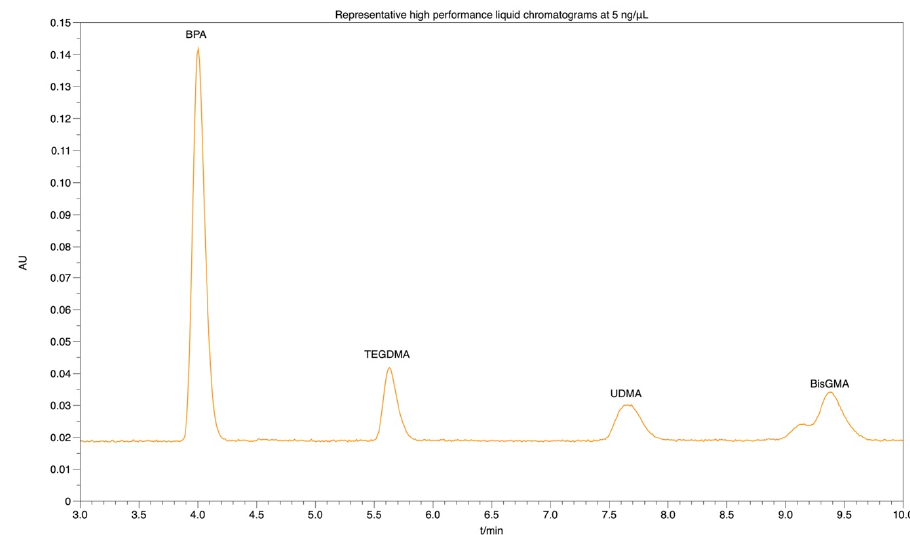
Figure 1. Representative high-performance liquid chromatograms at 5 ng/mL standard solution of BPA, TEGDMA, UDMA, Bis-GMA. Chromatographic conditions described in text. Bisphenol A ethoxylate dimethacrylate; Bis-GMA, bisphenol A-glycidyl dimethacrylate; BPA, bisphenol A; TEGDMA, triethylene glycol dimethacrylate; UDMA, urethane dimethacrylate. For the SEM-EDS, the specimens were examined by field-emission electron micros- copy (FESEM) (JSM 7610F PLUS; JEOL Ltd.). Elemental analysis was performed by en- ergy-dispersive X-ray spectrometry (EDS) (Oxford AZTEC); the analysis was conducted from the top to the bottom of the specimens and at three areas on the specimens, which were randomly selected by an examiner. Spectra were obtained under the following con-